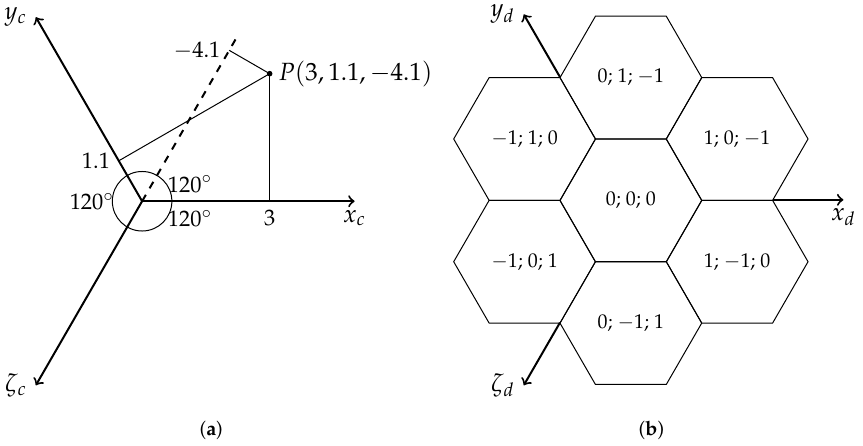
Figure 3. Cube coordinate system. ( a ) Continuous space with example point. ( b ) Discrete